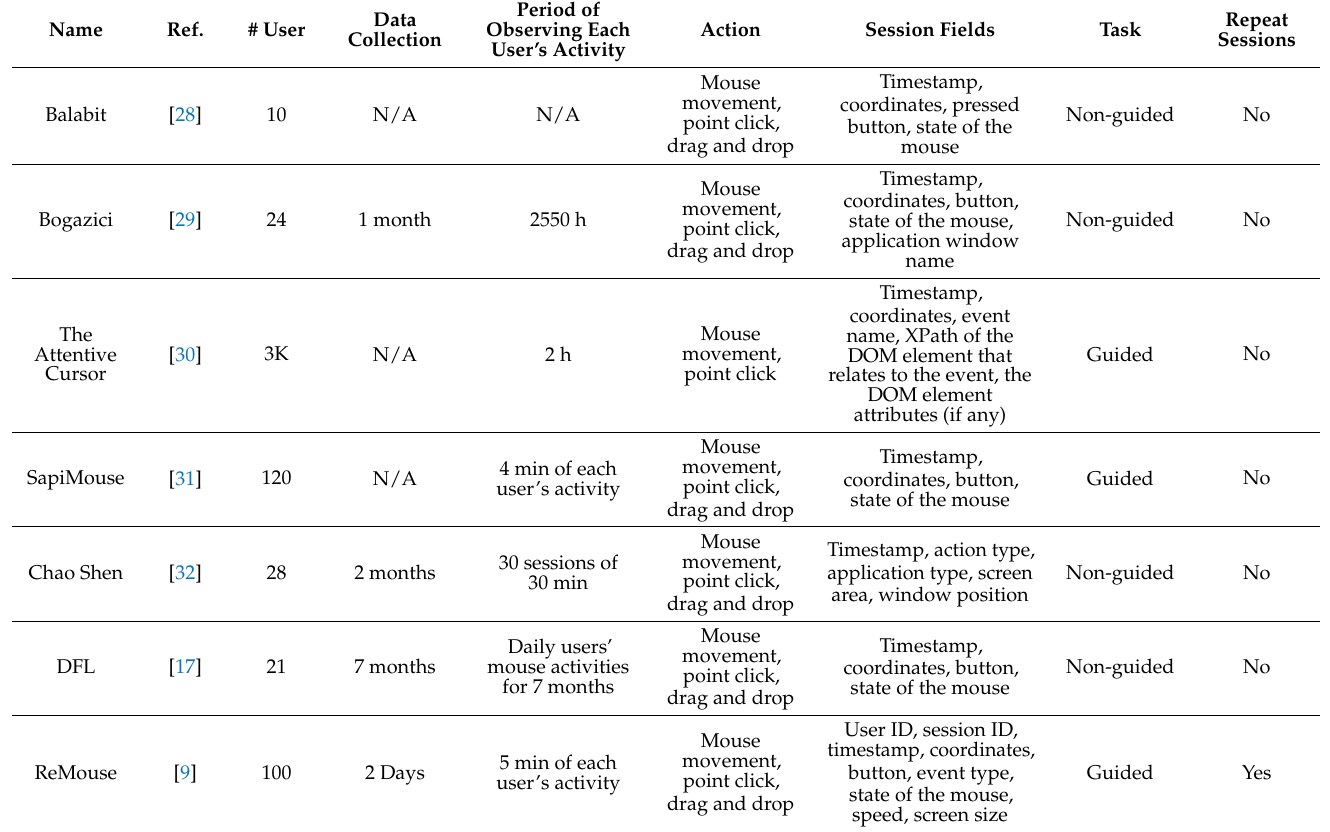
Table 1. The characteristics of the most prevalent publicly available dataset, including our novel ReMouse